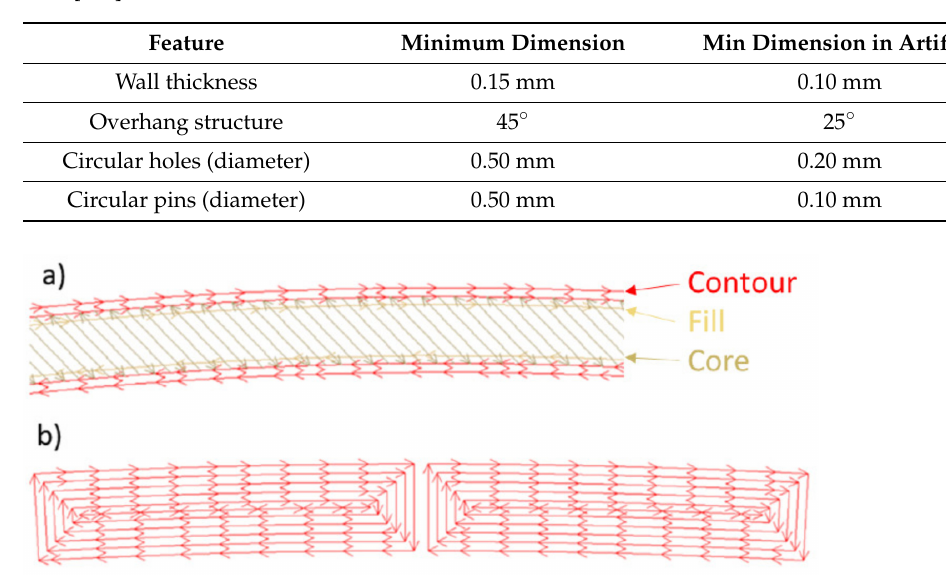
Figure 5. The Artifact with spiral on benchmarking in [105]. The figure is from [104]. Table 10. The minimum dimensions in the artifact in Figure 5 compared with the minimum dimension the most capable machine manufacturers claimed to be able to produce. Material = 18Ni-300 (DIN 1.2709). Seven (7) state-of-the-art L-PBF machines were used to produce 3 complete jobs (artifacts) each [105].